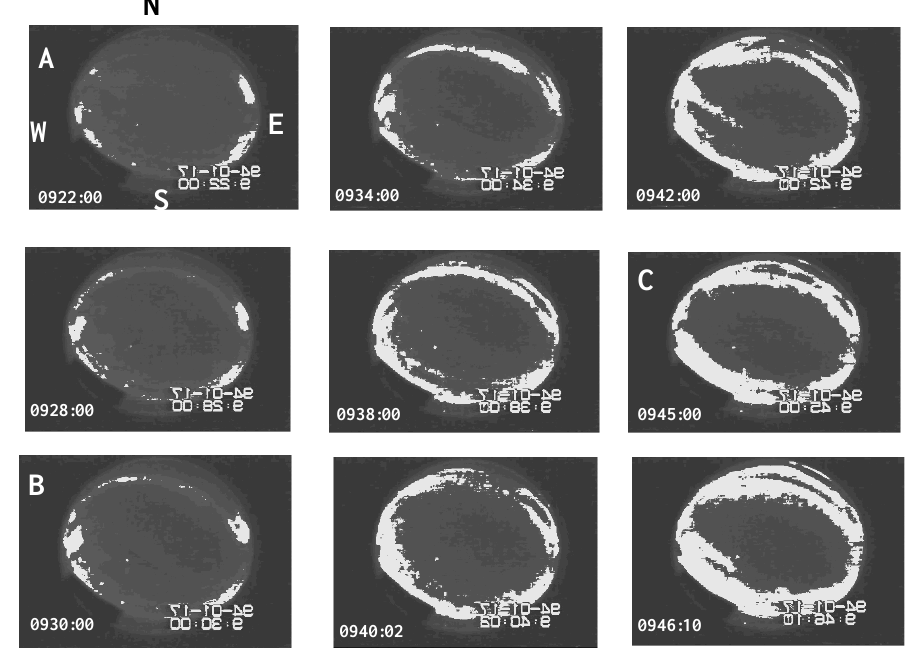
Figure 5. Same as Fig. 4 but the highlighted level is 0.350–0.370 in the gray level, slightly higher than that in Fig. 4 (the wave-like structure in Fig. 4 disappeared because of the weaker